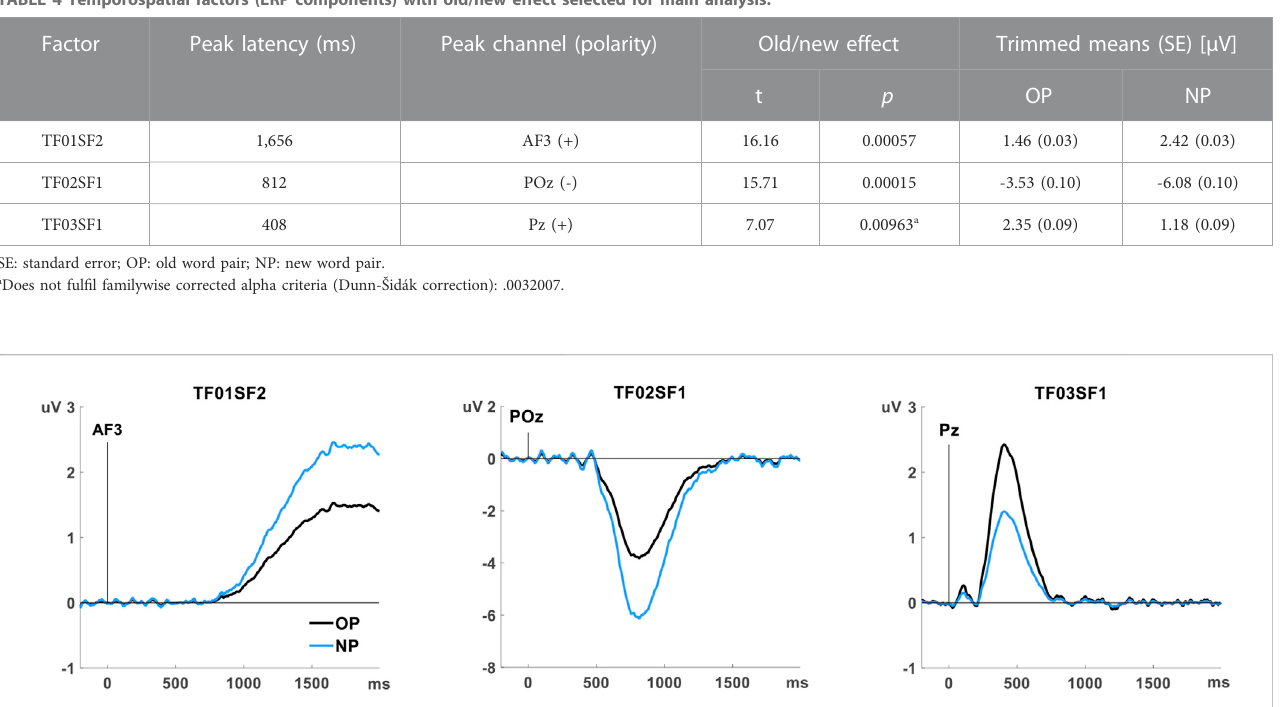
FIGURE 2 Temporospatial factors (ERP components) showing old/new memory effects, rescaled to µV at the channel with the peak amplitude. Grand average for the old word pairs (OP, black line) and the new word pairs (NP, blue line).